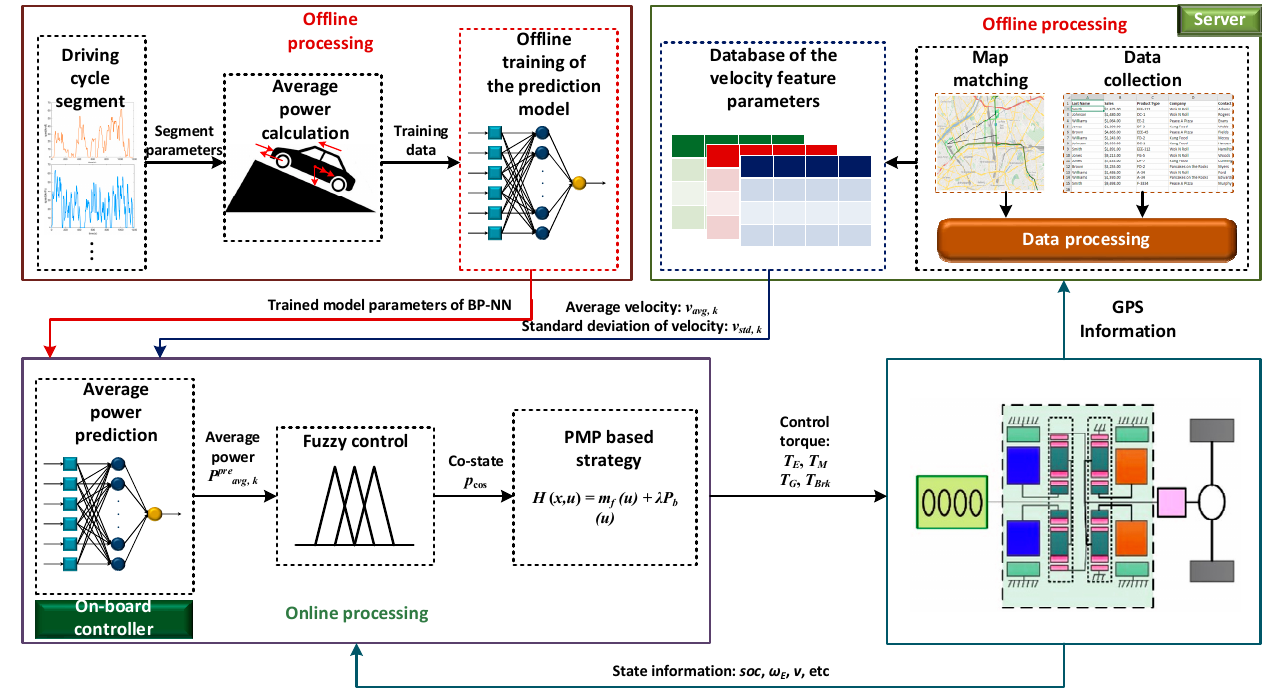
Figure 23. The control scheme of the proposed strategy in EV applications.